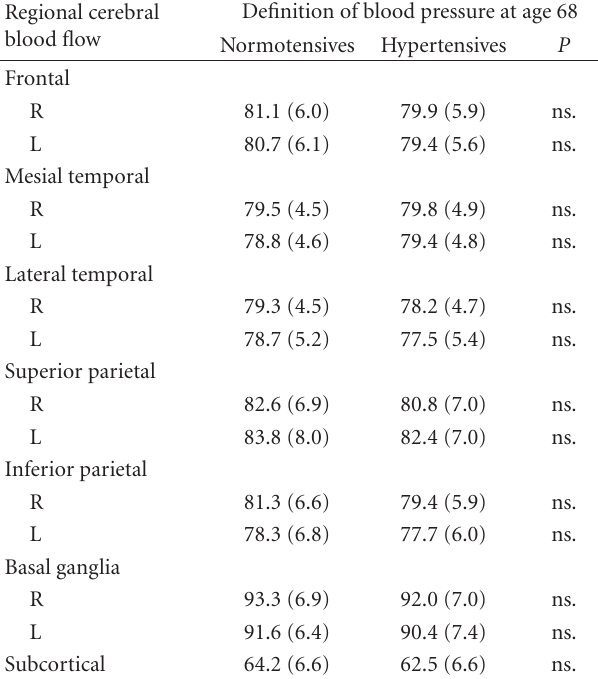
Table 5: Distribution of cerebral blood flow values in di ff erent brain areas in subjects defined as normo- or hyper-tensive at age 68. blood